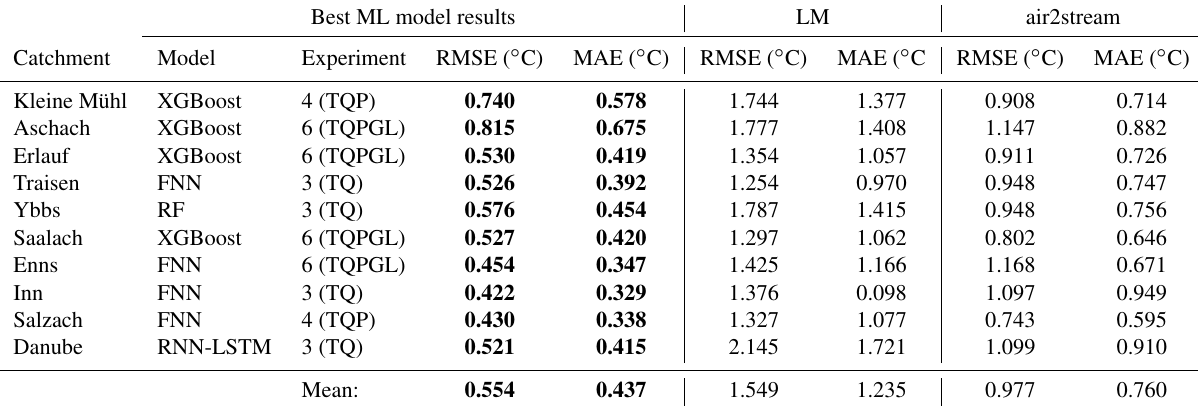
Table 4. Overview of model performance of the best machine-learning model for each catchment and the two reference models. The best- performing model results in each catchment are shown in bold font. The best machine-learning model for each catchment was chosen by comparing validation RMSE values, while test RMSE and test MAE values were never part of any selection or training procedure. The shown values all refer to the test time